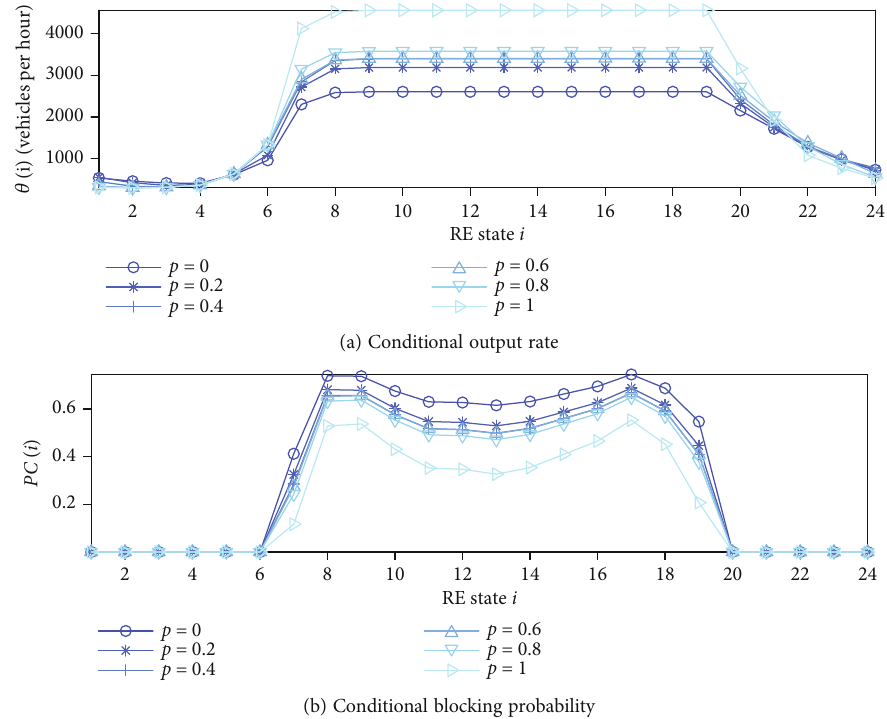
Figure 6: Varying performance measures when l = 4